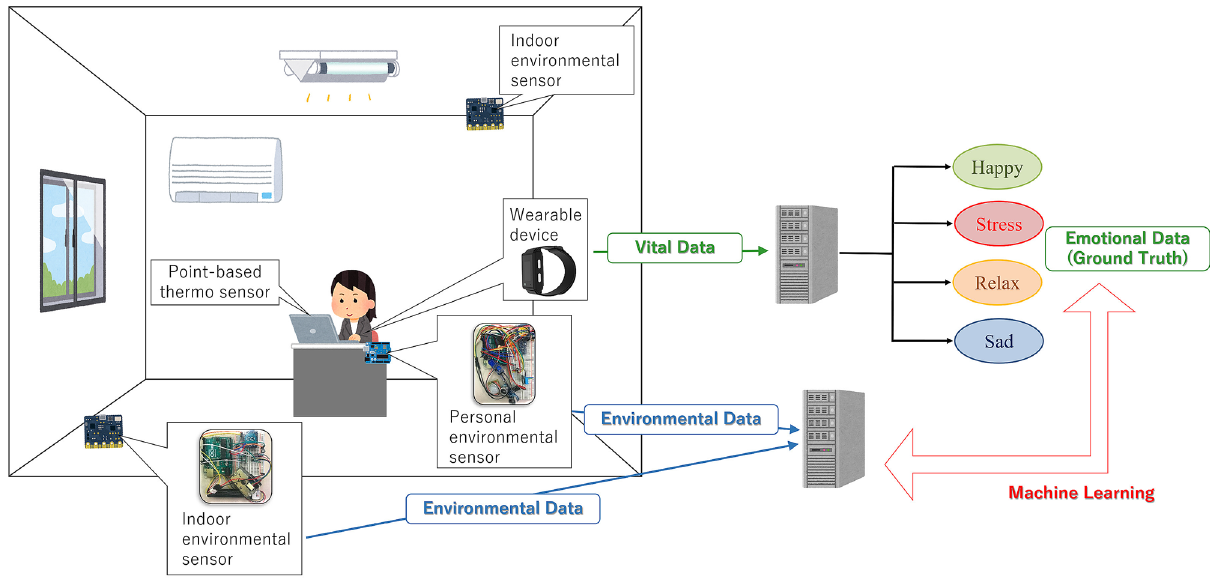
Figure 1. Individual emotion estimation from perception-based sensor